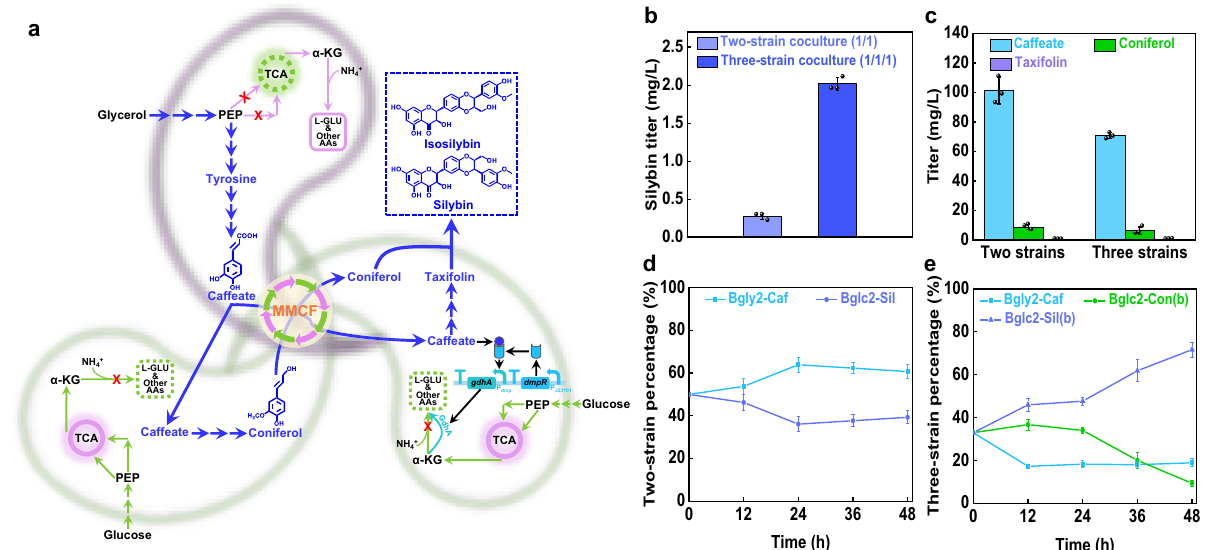
Fig. 5 Production of silybin/isosilybin using coculture engineering. a Schematic of the three-strain coculture to accommodate the silybin/isosilybin biosynthetic pathway and convert a glycerol and glucose mixture to silybin/isosilybin (The silybin/isosilybin biosynthetic pathway is shown in blue. For the detailed pathway, see Supplementary Fig. 5). b Silybin/isosilybin titers. c Amounts of the intermediates accumulated. d Population change of the two-strain coculture. e Population change of the three-strain coculture. MMCF multi-metabolite cross-feeding. Genes: gdhA encodes glutamate dehydrogenase, gltBD encodes glutamate synthase. Enzymes: GdhA glutamate dehydrogenase, DmpR the caffeate-responsive transcription factor. Metabolites: PEP phosphoenolpyruvate, α -KG α -ketoglutarate, L-GLU L-glutamate, AAs amino acids. Data shown are mean ± SD ( n = 3 independent experiments). Source data are provided as a Source Data fi